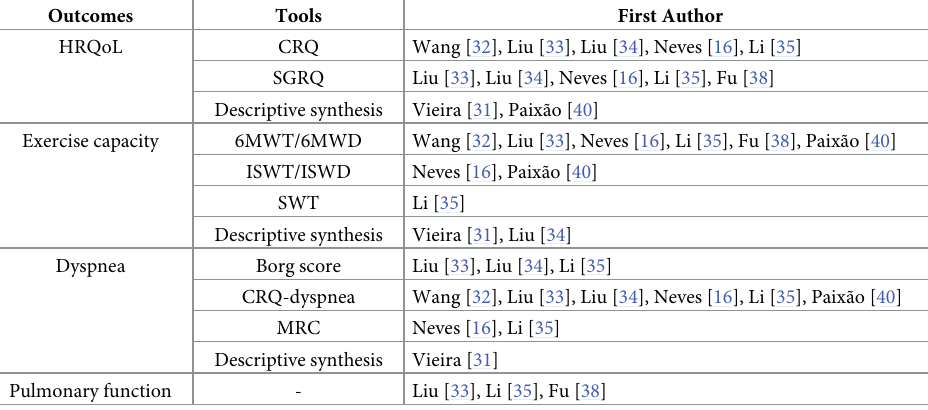
Table 3. HPR versus control groups.